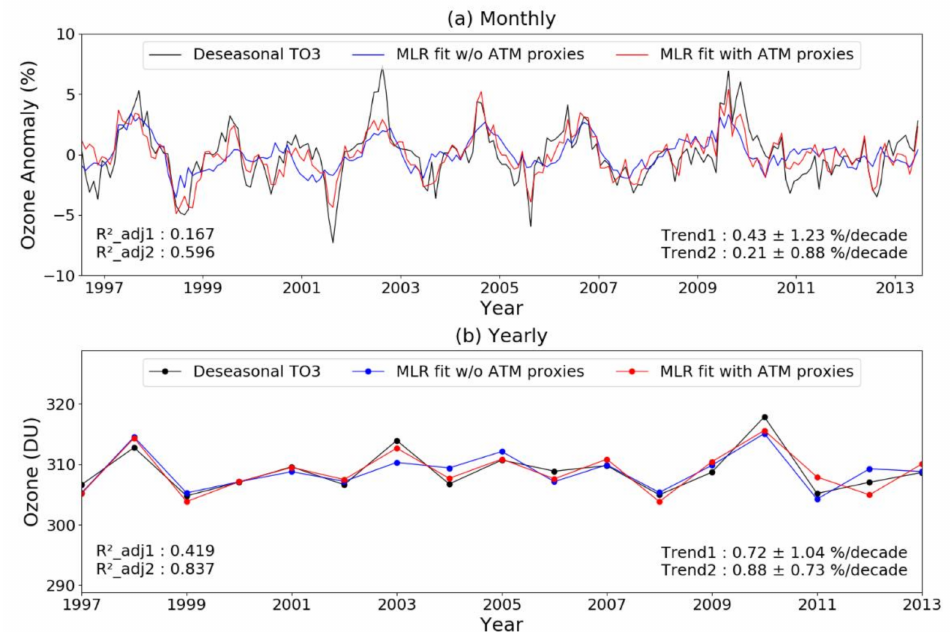
Figure 4. Time-series of SBUV zonal averaged total column ozone in latitudes between 35–40 ◦ N according to the use of atmospheric proxies. Both the monthly ( a ) and yearly ( b ) MLR fitted data are presented for comparison. The MLR fitted data without atmospheric proxies are indicated as blue lines and correspond to Trend1 and R 2 _adj1 while the MLR fitted data with the atmospheric proxies are indicated as red lines and correspond to Trend2 and R 2